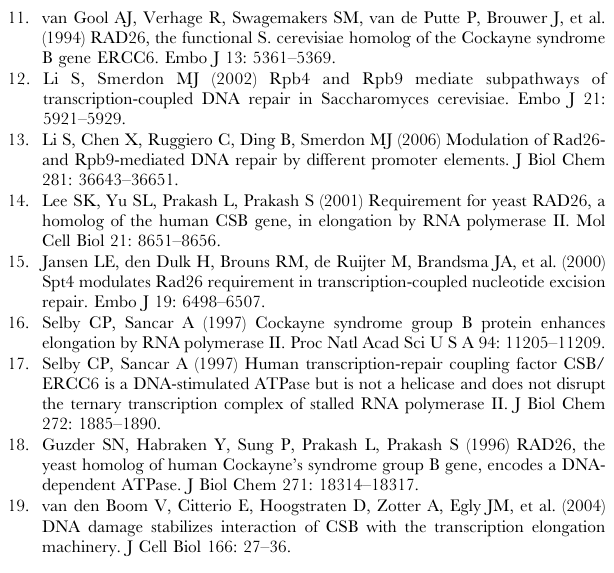
Figure S1 RNA polymerase II occupancy in different ORFs of the RPB2 locus in absence of UV irradiation. ChIP analysis of RNA polymerase II occupancy in ORF1, ORF2